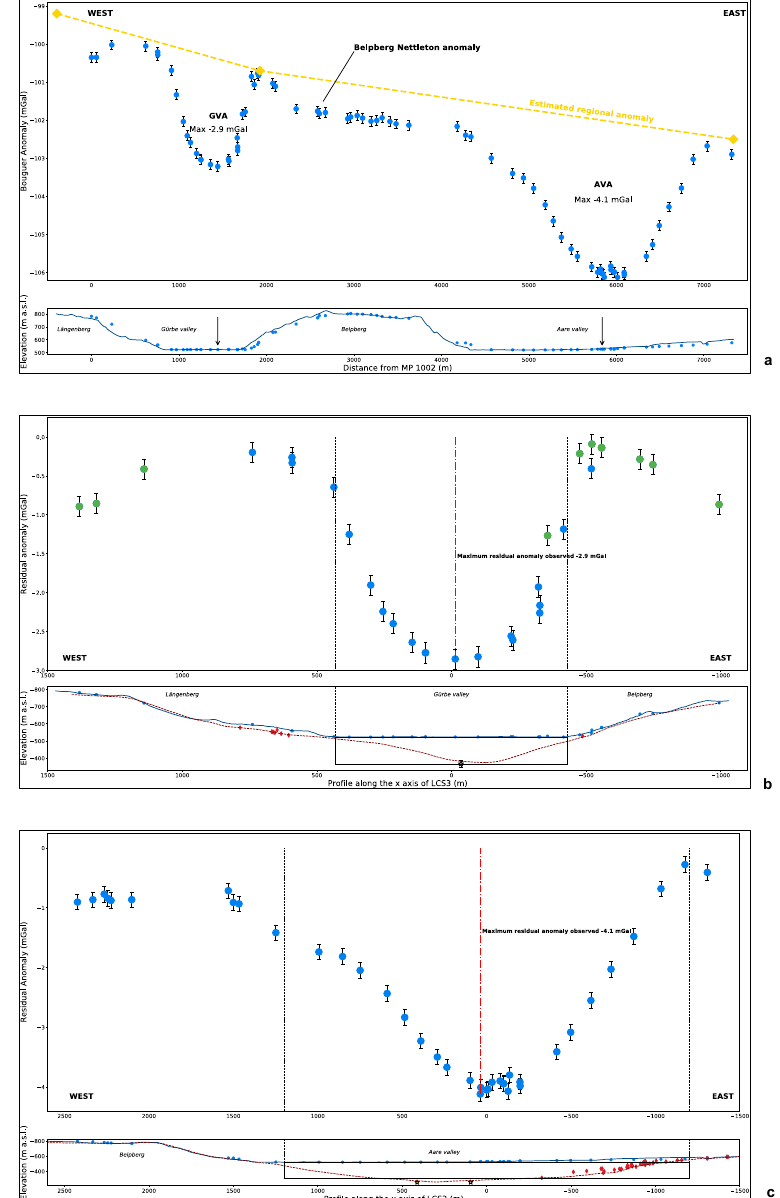
Figure 4. Bouguer and residual anomalies. ( a ) Top: Regional Bouguer anomaly plot. The blue dots indicate the Bouguer anomaly measured at a station; the black bar is the related uncertainty of +/− 0.13 mGal. The yellow diamonds indicate the points used to estimate the regional Bouguer gravity (dashed yellow line, see Fig. 3), which would be measured if there were no local anomalies. These anomalies are the Gürbe Valley Anomaly (GVA) of − 2.9 mGal, the Aare Valley Anomaly (AVA) of − 4.1 mGal, and the Belpberg Nettleton anomaly (Tables S2 and S3). The western end of the profile points to an anomaly possibly due to the bedrock underlying the Längenberg and the moraine cover. This anomaly is not further used. Bottom: Plot of the elevation of the gravity profile (see Fig. 3 for location) with the stations’ elevations, represented by the blue line and dots, respectively. Due to the projection of the elevation profile onto a line some stations are offset. The black arrows indicate the stations with the maximum GVA and AVA values. ( b ) Top: Residual anomaly plot of the Gürbe valley. The values are the difference between the measured Bouguer anomalies and the regional trend. The blue dots represent the stations < 100 m away from the gravity profile, whereas the green dots are the stations at > 100 m distance. The black dashed lines indicate the border of the valley floor, which delimit our models’ widths. Bottom: The bedrock profile of Reber and Schlunegger 12 is indicated by the red dashed line with red diamonds showing the drillings that reached the bedrock. These are used as constraints for the modelling. The black rectangle is the cross-section of the first model approximating the geometry of the valley. ( c ) Top: Residual anomaly plot for the Aare valley, calculated in the same way as for the Gürbe valley. Bottom: Elevation and bedrock model profiles together with cross section of the prism that is used as a first order model of the Aare valley (see (b) for the legend). Note that the stations are not differentiated by distance to the profile because this will not yield an added value. Yellow stars in (b) and (c) indicate the depths of drillings shown in Figs. 2 and